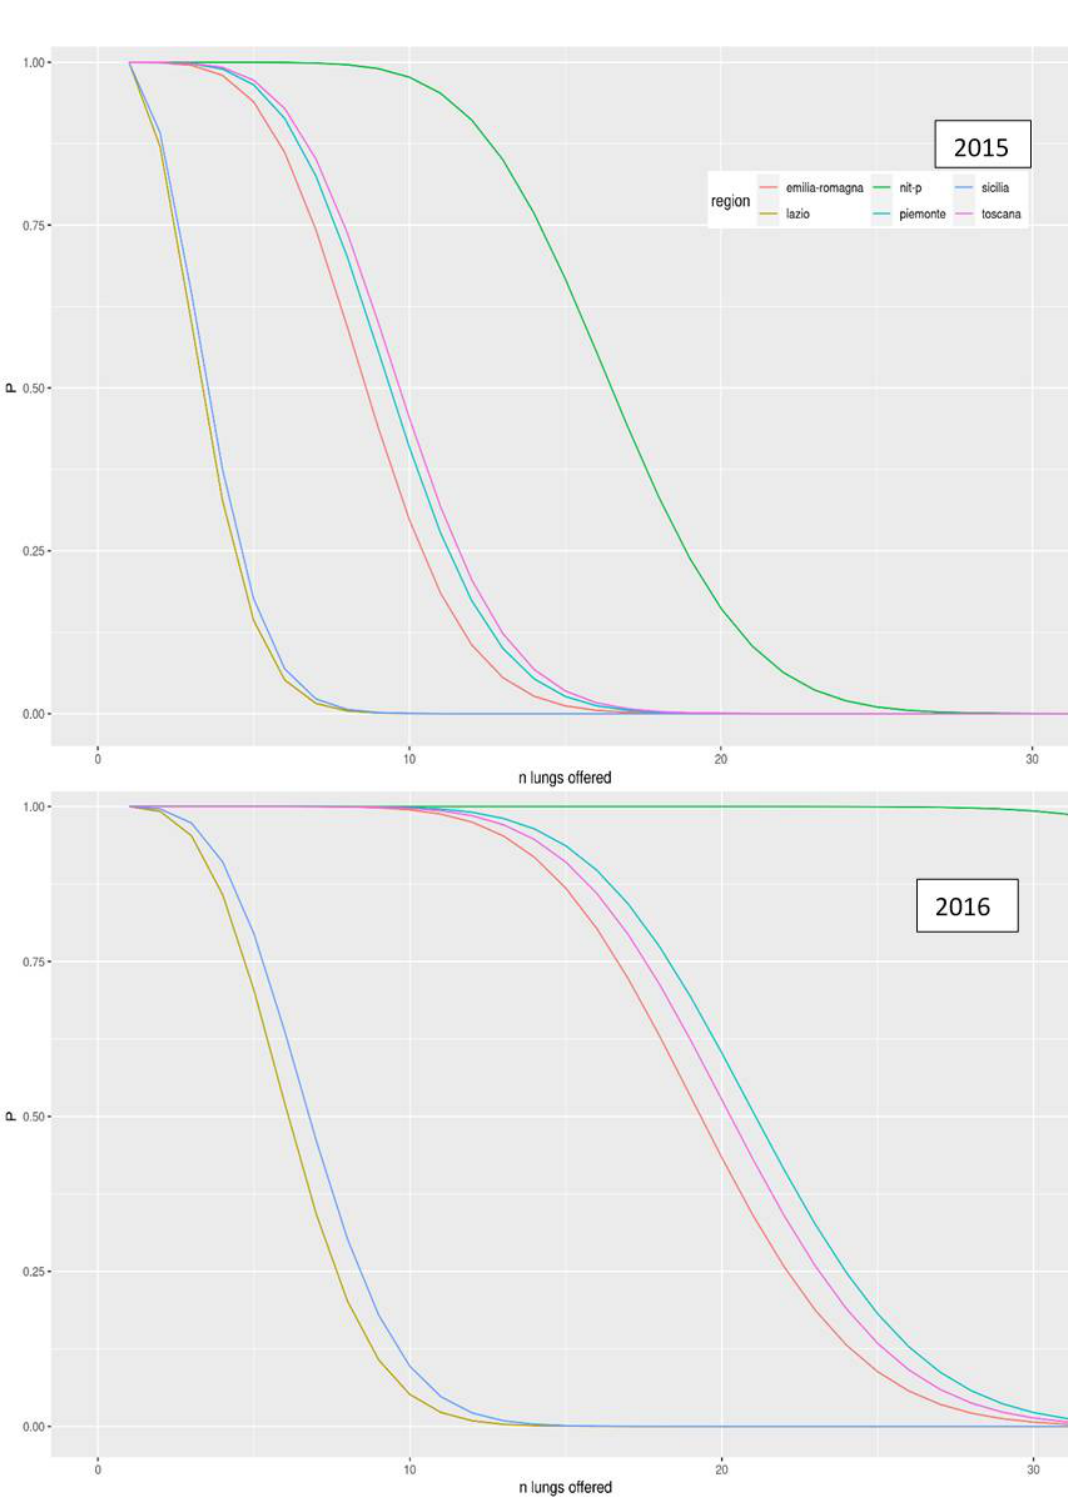
Figure 4. Trend of the probability that at least n-th lung will be offered and accepted by each region as the number of lungs donated increases for the years 2015 and 2016.